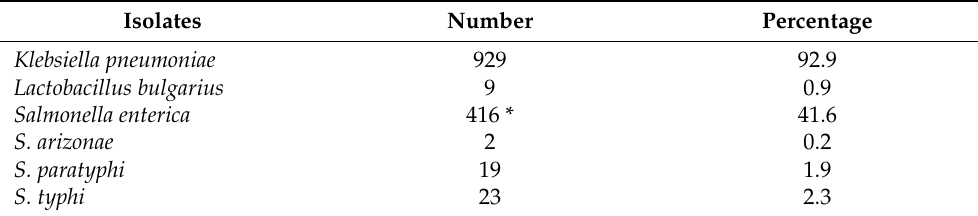
Table 2. Descriptive analysis of the respondents’ variables for the incidence of non-typhoidal Salmonella in poultry farms, North Central